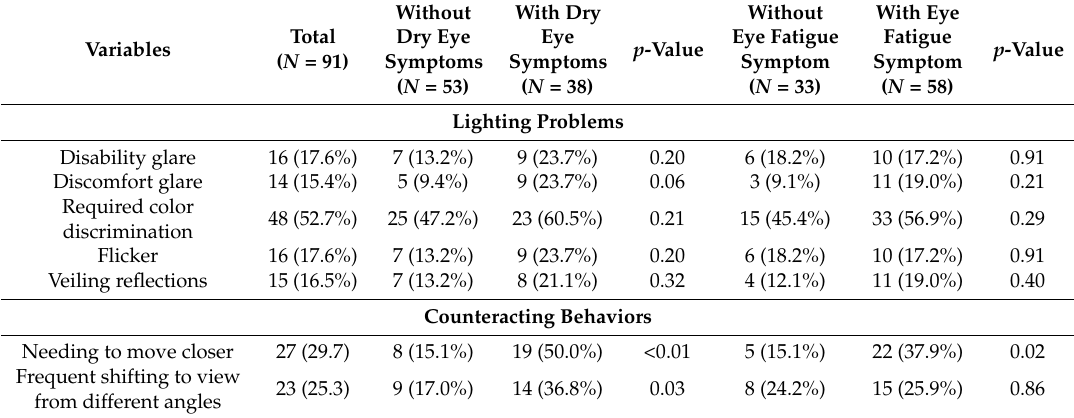
Table 2. Distribution of lighting problems and counteracting behaviors, stratified by symptoms of dry eye and eye fatigue.